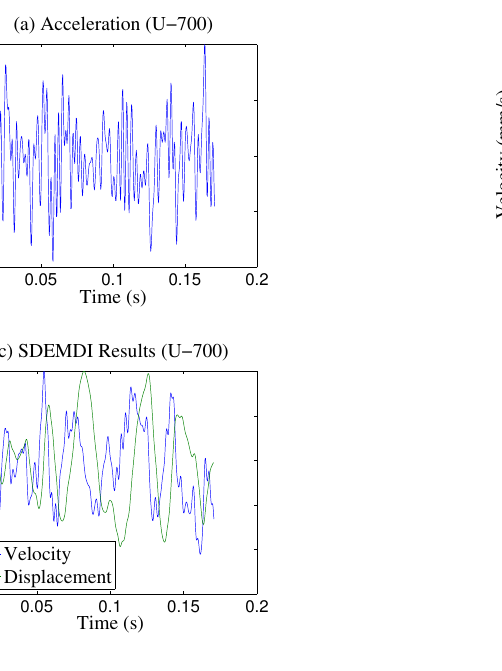
Figure 8. Transformation of acceleration into velocity by detrending with the SDEMDI method for Case 1 at 700 rpm: ( a ) Acceleration signal; ( b ) velocity resulting from integration with its trend; ( c ) corrected velocity and